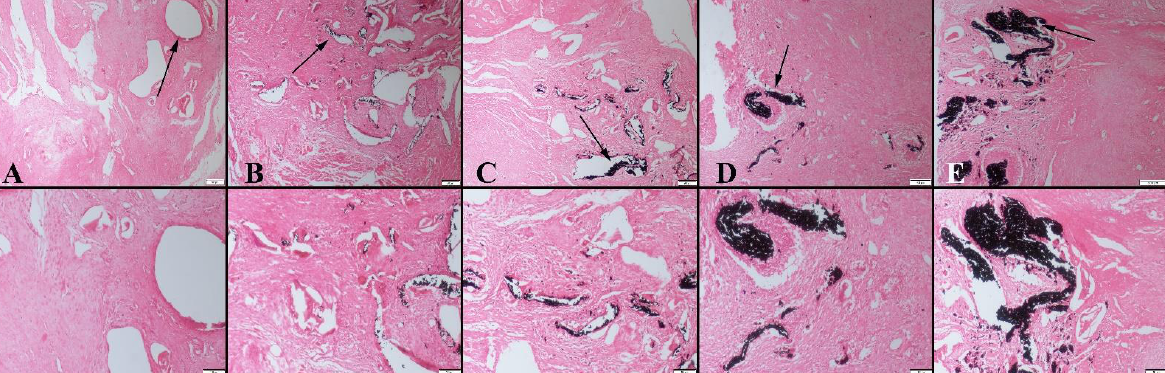
Figure 6. Representative histopathological micrographs of bone fracture areas of(upper row) at 4-week groups, ( A ) Control group, ( B ) Group 1, ( C ) Group 2, ( D ) Group 3 and ( E ) Group 4 lower row higher magnification, graft materials (indicated by arrows), HE, Bars = 200 µm (for upper row) and 100 µm (for lower row).